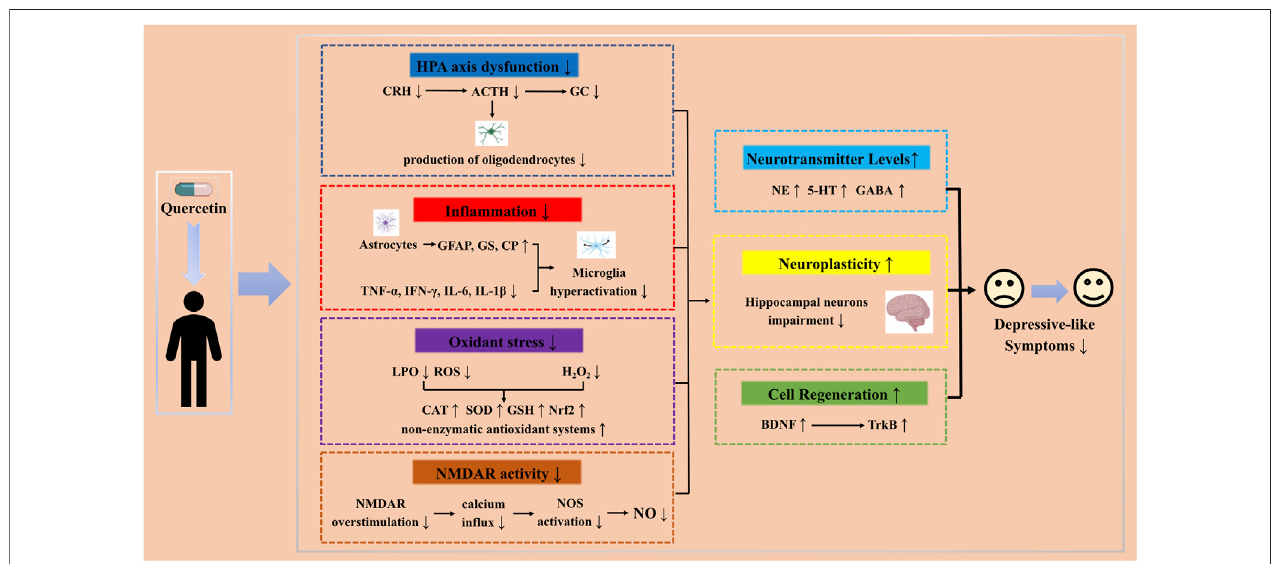
FIGURE 3 | Schematic representation of different pathways and targets by quercetin as a potential therapeutic strategy in